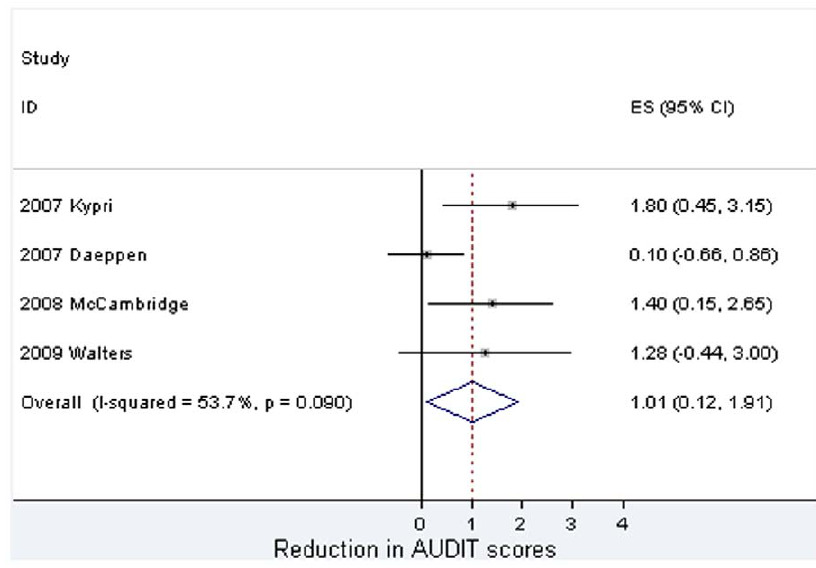
Figure 4. Meta-analysis of the effects of answering questions on total AUDIT scores.